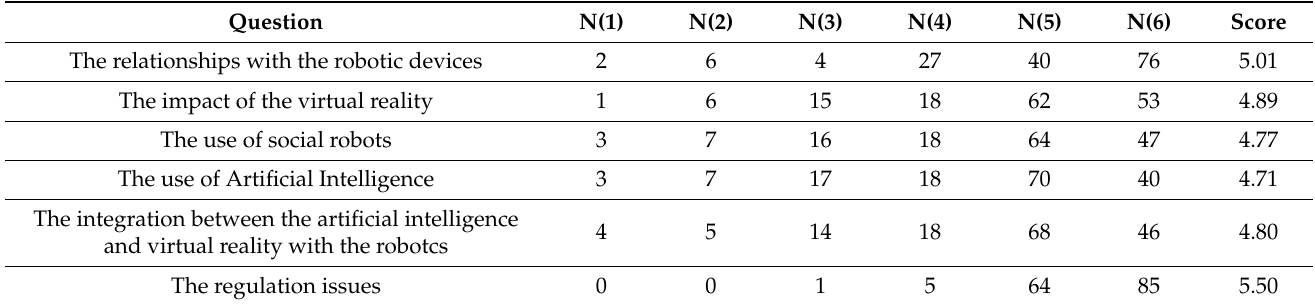
Table 4. Output from the Likert question “Regarding the organizational aspects, what would you suggest to improve in terms of training and/or in-depth study in the field of ethics in robotic rehabilitation in the neurological